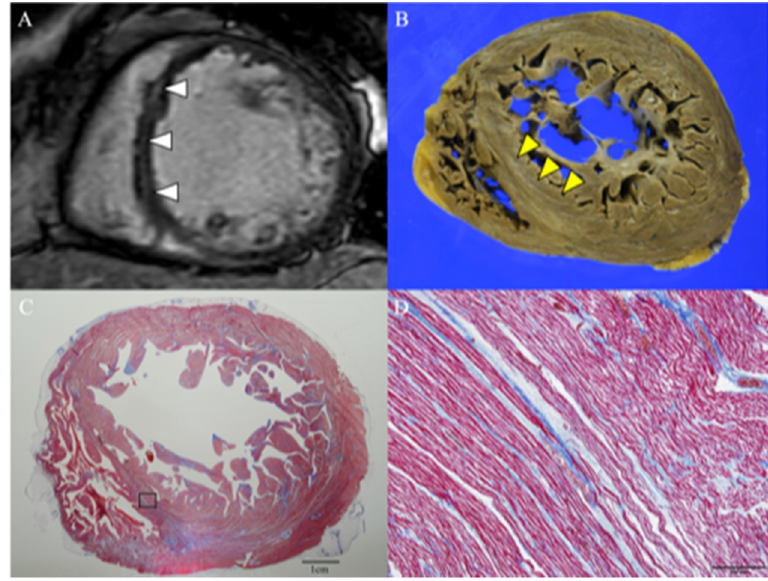
Figure 1. Cardiac Magnetic Resonance Imaging and Histopathological Findings. Cardiac magnetic resonance (CMR) short-axis image of the mid-ventricle revealed a linear late gadolinium enhancement (LGE) of the septal wall (arrow) ( A ). Macroscopic autopsy image corresponding to the CMR image showed fibrosis in the mid-ventricle septal wall (arrow) ( B ). Loup image showed diffuse fibrosis (blue) in the Masson’s trichrome stained ventricular myocardium sample ( C ). Magnitude image ( × 100) from a region of LGE in the above CMR image demonstrated a thinning and wavy change in cardiomyocytes and massive interstitial fibrosis and edema ( D ).